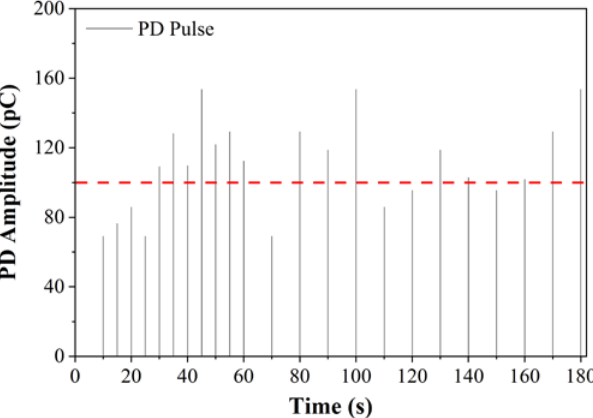
Figure 3. PD pulses recorded at 30 kV applied voltage for three minutes.